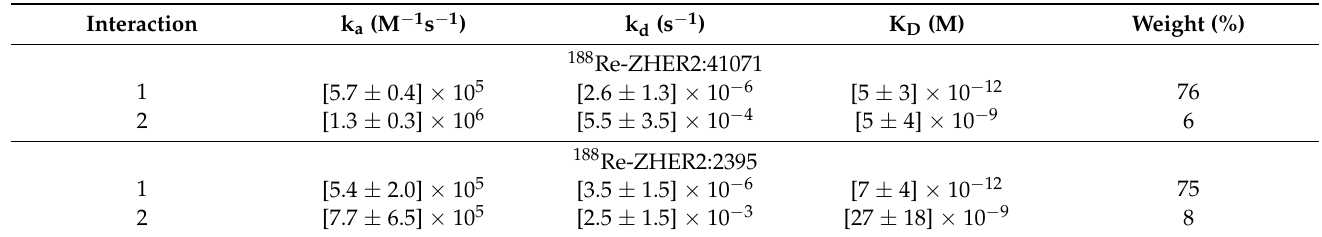
Figure 2. LigandTracer sensorgrams of 188 Re-ZHER2:41071 ( A ) and 188 Re-ZHER2:2395 ( B ) binding to HER2-expressing SKOV3 cells and results of InteractionMap analysis of binding of 188 Re-ZHER2:41071 ( C ) and 188 Re-ZHER2:2395 ( D ). Binding was measured at concentrations of 0.1 nM and 0.3 nM. Data are representatives from duplicates. Table 1. Apparent kinetic parameters of 188 Re-ZHER2:41071 interaction with HER2-expressing SKOV-3 cells.